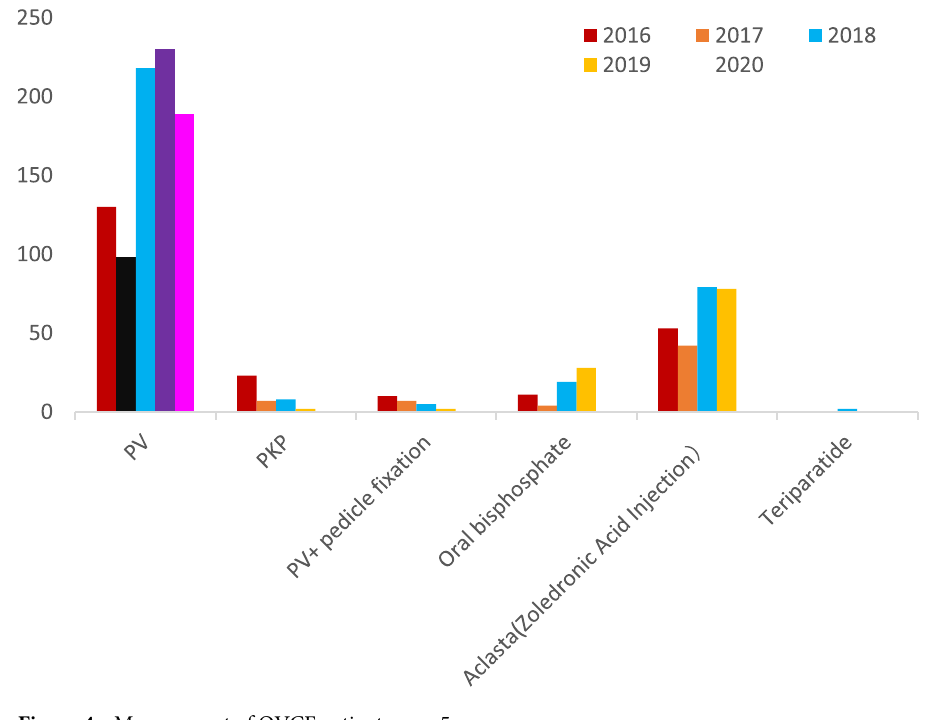
Figure 4. Management of OVCF patients over 5 years.